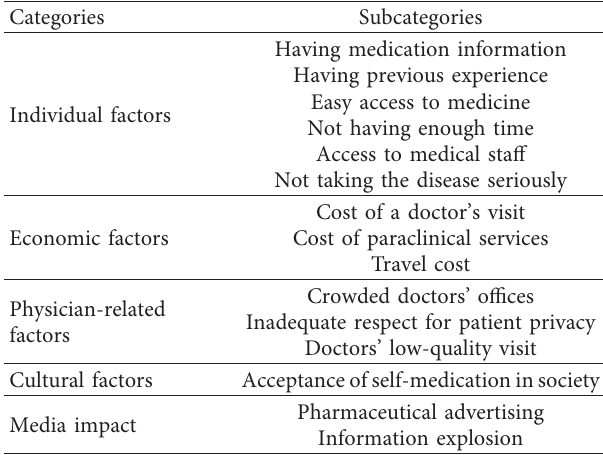
Table 1: Categories and subcategories related to the nursing students’ perspectives about the reasons for